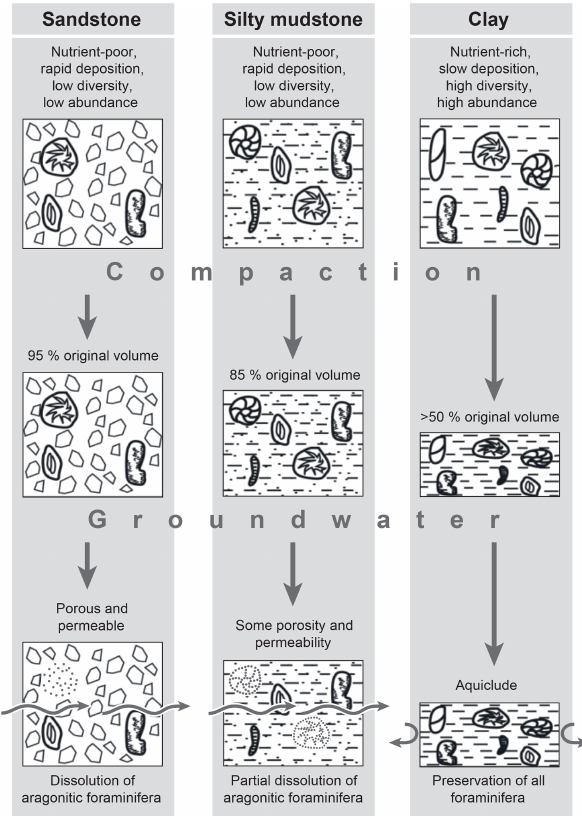
Figure 6. Model for the preservation of the microfossil assemblage and compaction of sediments from the Oxford Clay